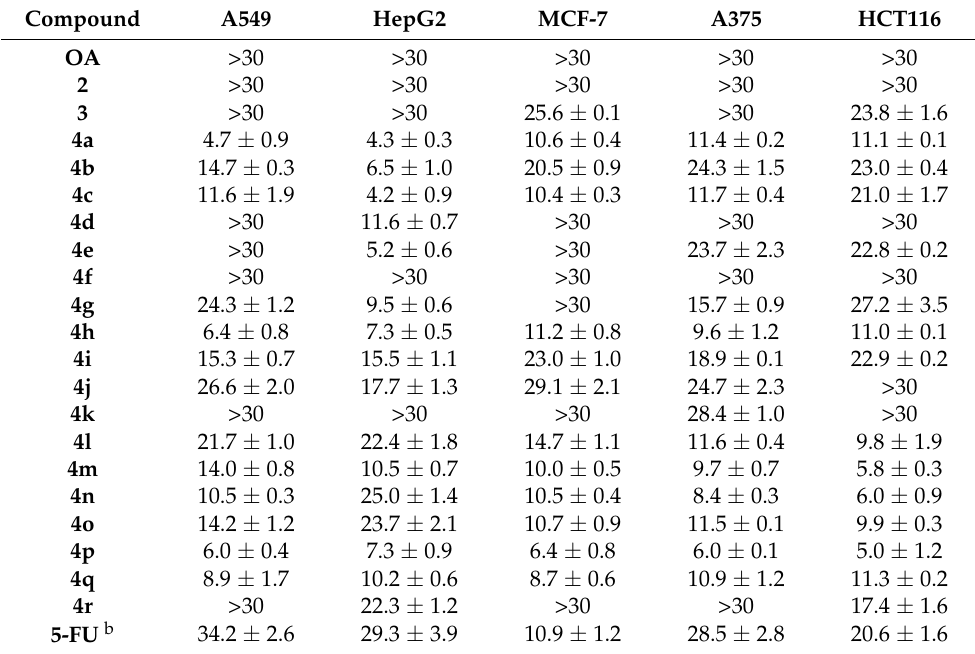
Table 1. IC 50 ( µ M) a values of neoaglycone 3 and neoglycosides 4a–4r against five human cancer cell